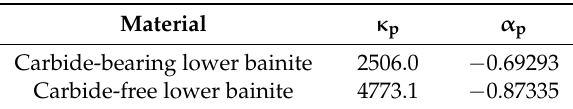
Table 6. Summary of the energy-life properties.